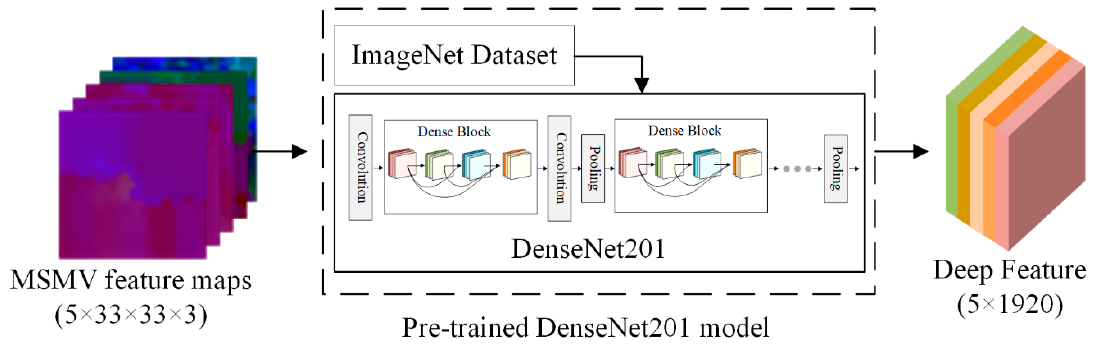
Figure 5. Deep feature extraction based on pre-trained DenseNet201 model.